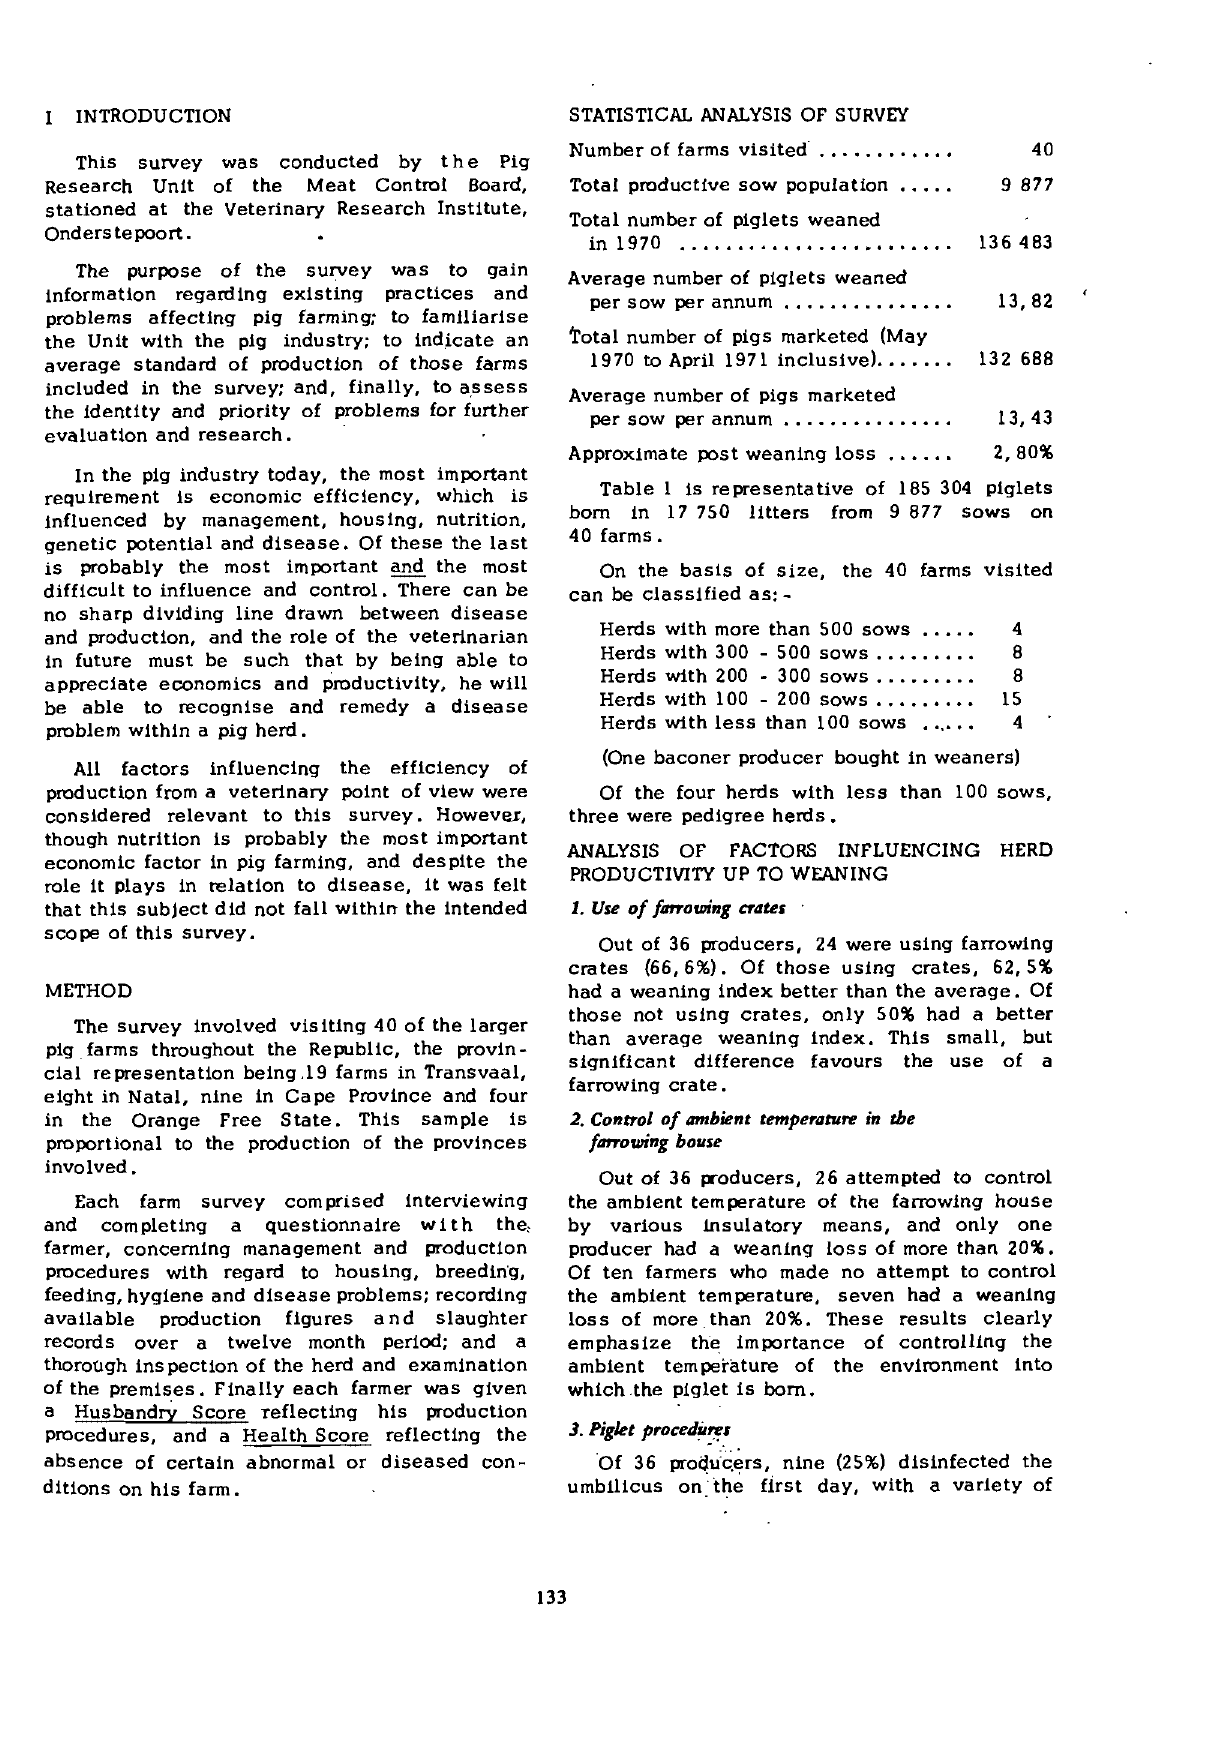
Table 1 is representative of IB5 304 piglets born in 17 750 litters from 9 B77 sows on 40 farms. On the basis of size, the 40 farms visited can be classified as: - Herds with more than 500 sows. . ..